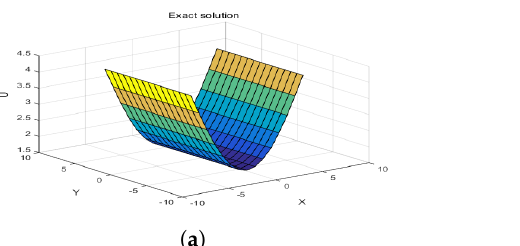
Figure 5. Example 2: δ = 1 × 10 − 10 , z = 0.3: ( a ) Exact solution, and ( b ) approximation solution.